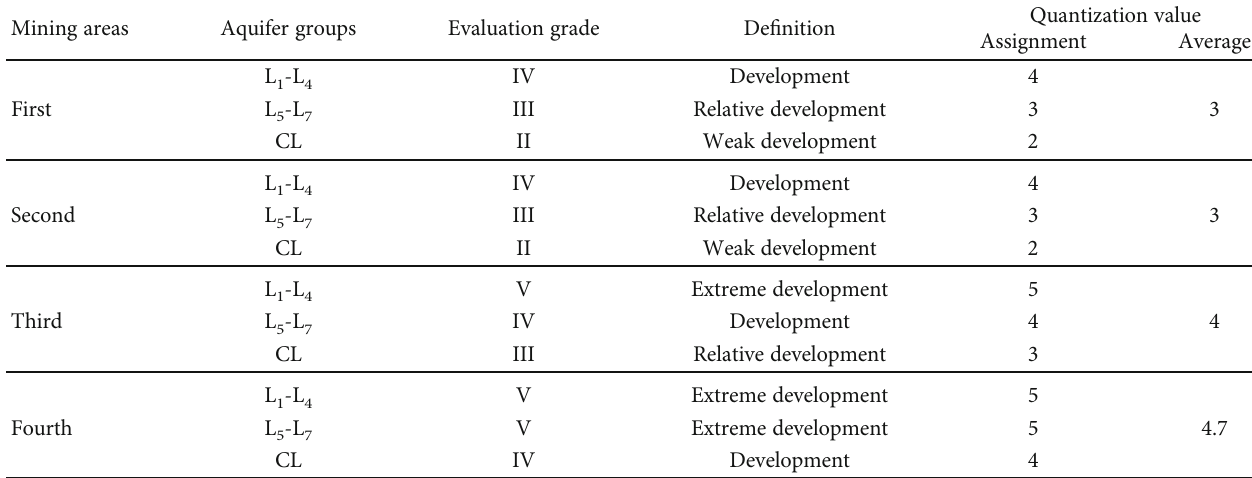
Table 7: Degree of karst development in di ff erent mining areas of mine No. 13. Mining